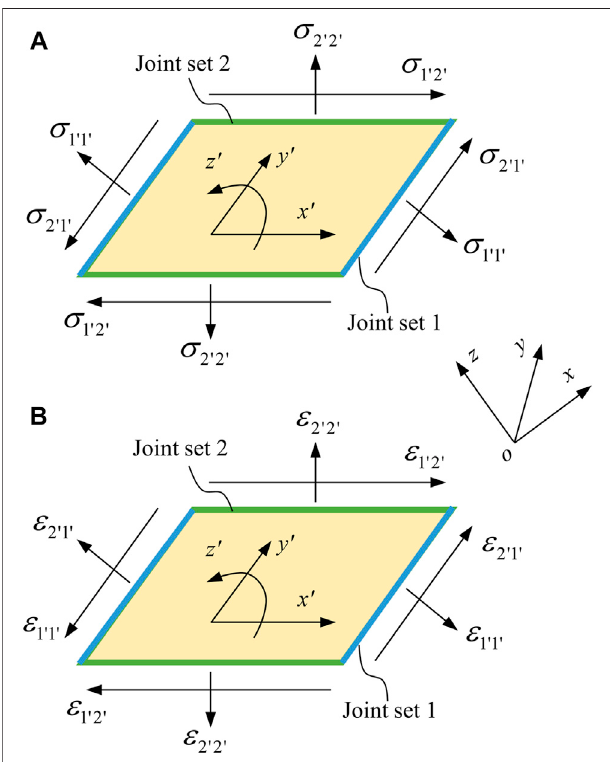
FIGURE 2 | Stress (A) and strain (B) components of CJRM in the local coordinate system.